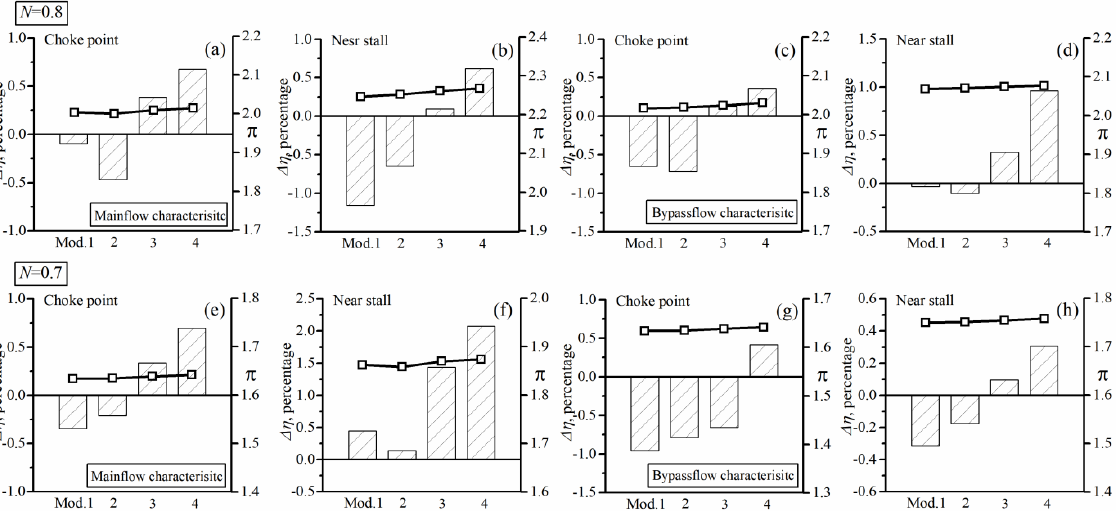
Figure 11. The influence of R2 and S1 modifications in double flow-path mode (DFM) ( a – d ) for N C = 0.8 and ( e – h ) for N C = 0.7.